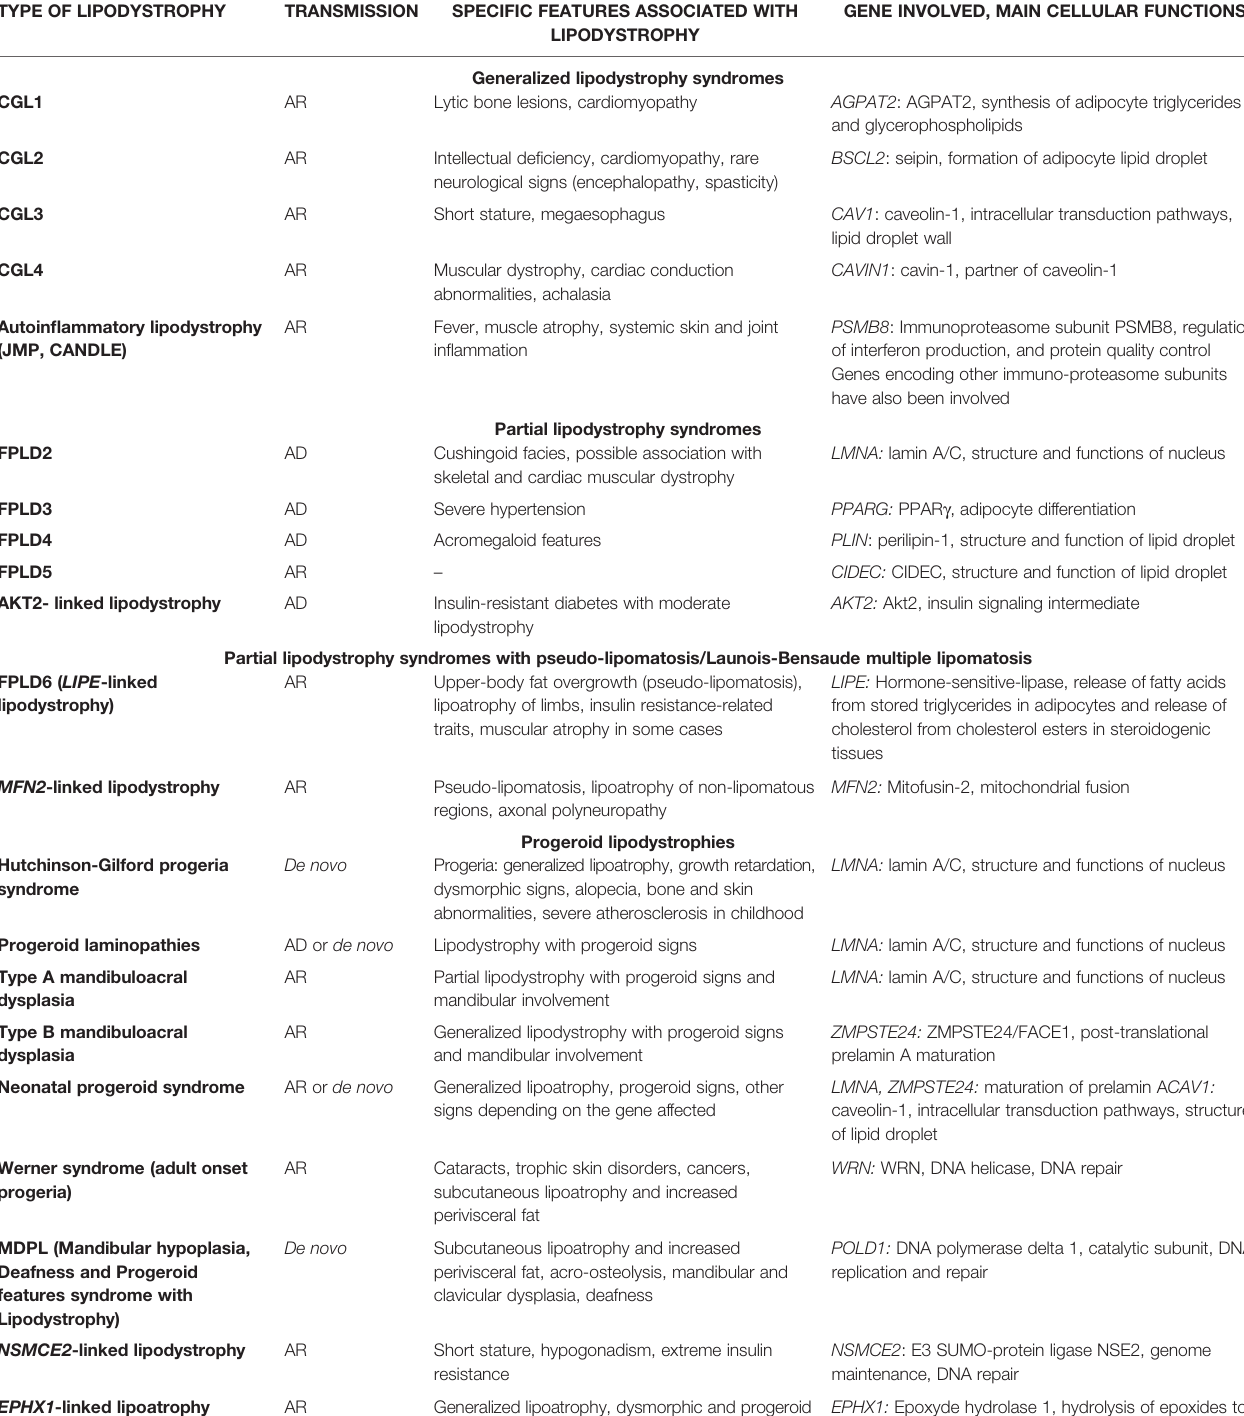
TABLE 1 | Main forms of monogenic lipodystrophy